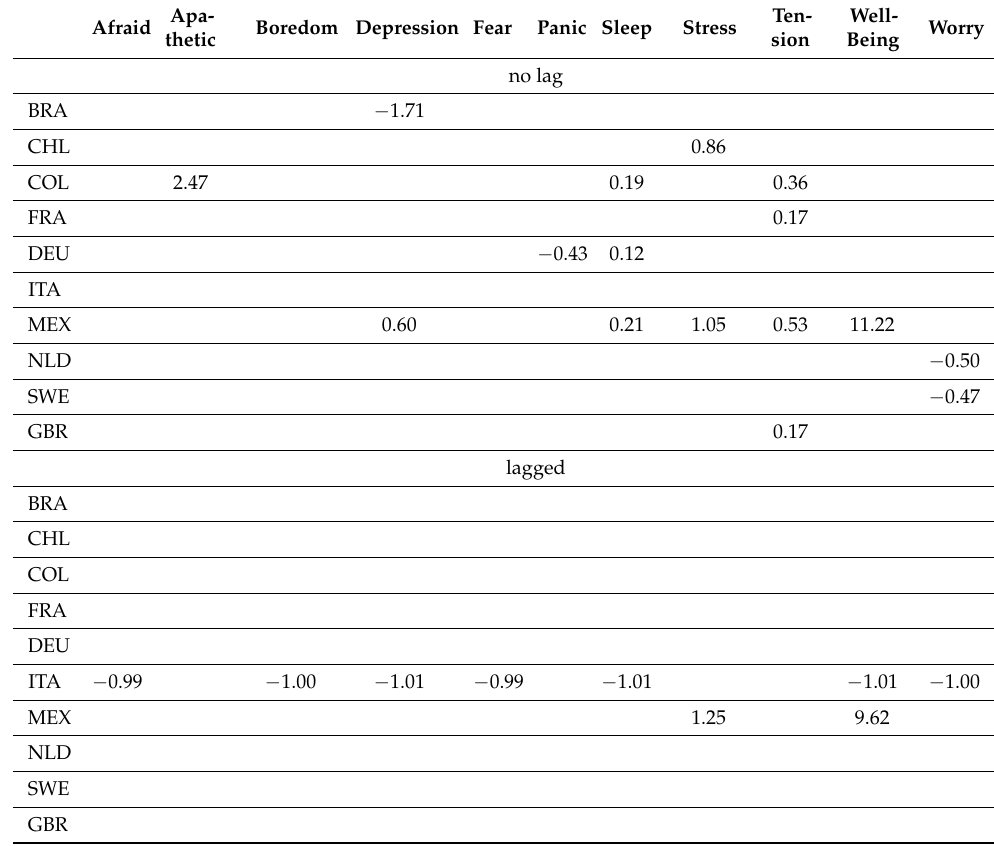
Table 8. Relative effects detected by BSTS_3_l and BSTS_3 models (columns representing words with no relative effects found in any country are